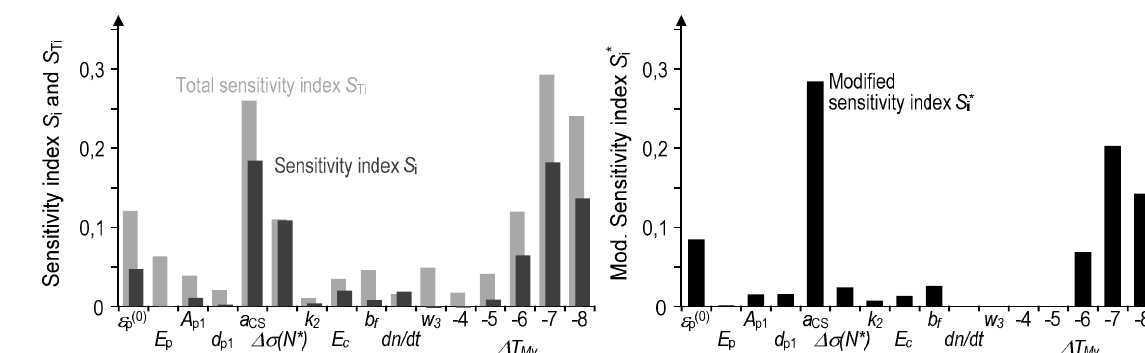
Figure 7. Original and total ( left ) versus modified sensitivity indices ( right ) for the reference bridge.